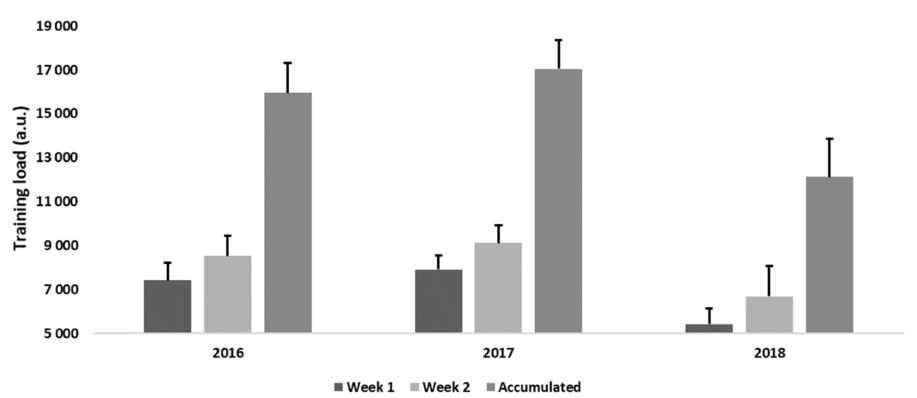
Figure 1. Training load patterns during 2-week national team training camp in different years.